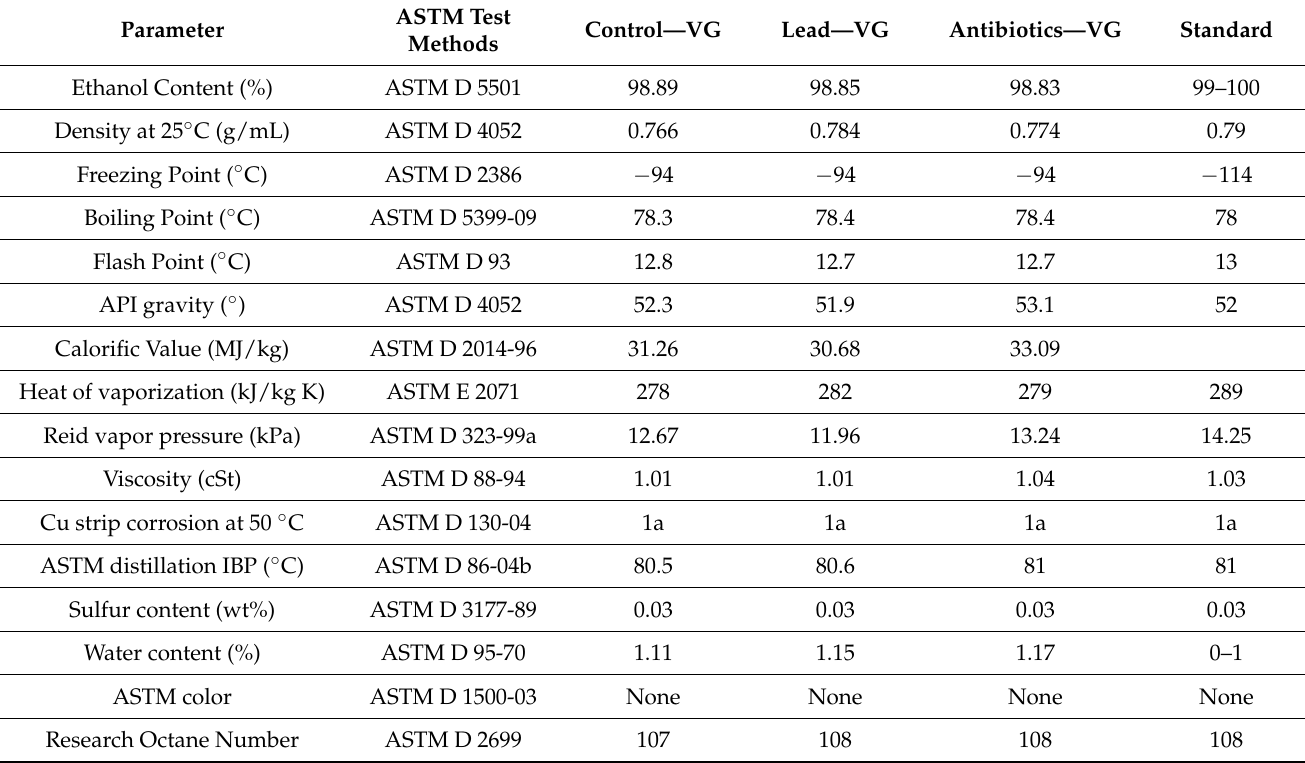
Table 3. Comparison of bioethanol quality of VG with